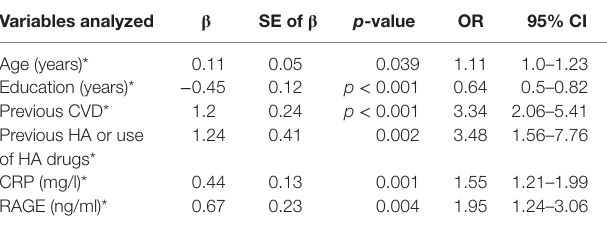
TaBle 5 | assessment results of the risk of having Mci in a multivariable logistic regression model in elderly patients with type 2 diabetes. Variables